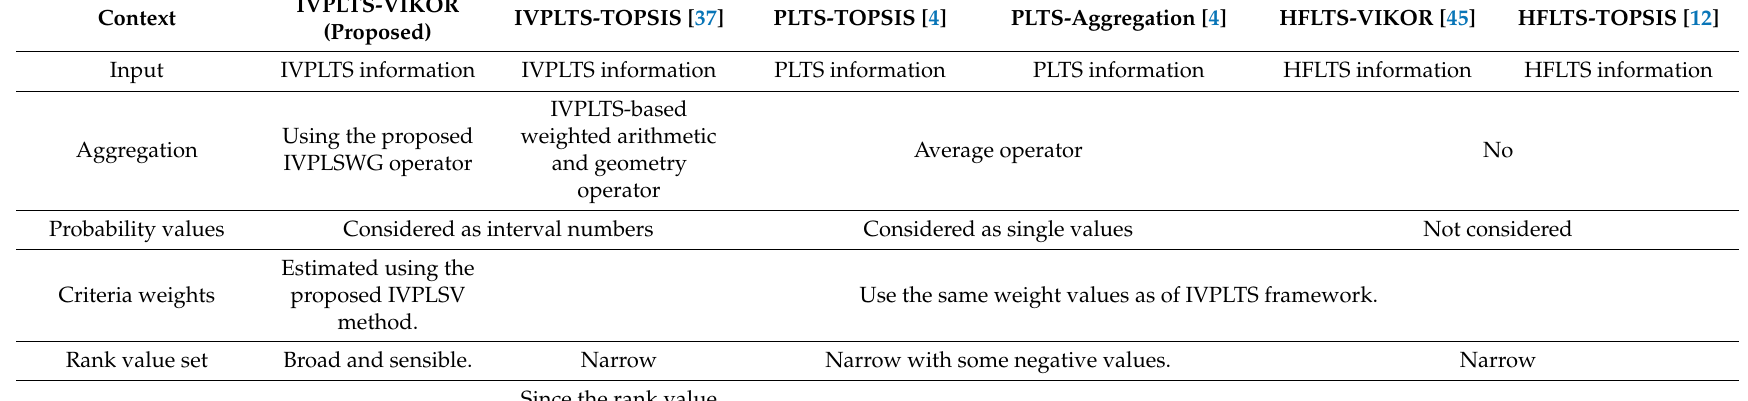
Table 7. Investigation of salient features and innovations: Proposed IVPLTS decision framework vs.